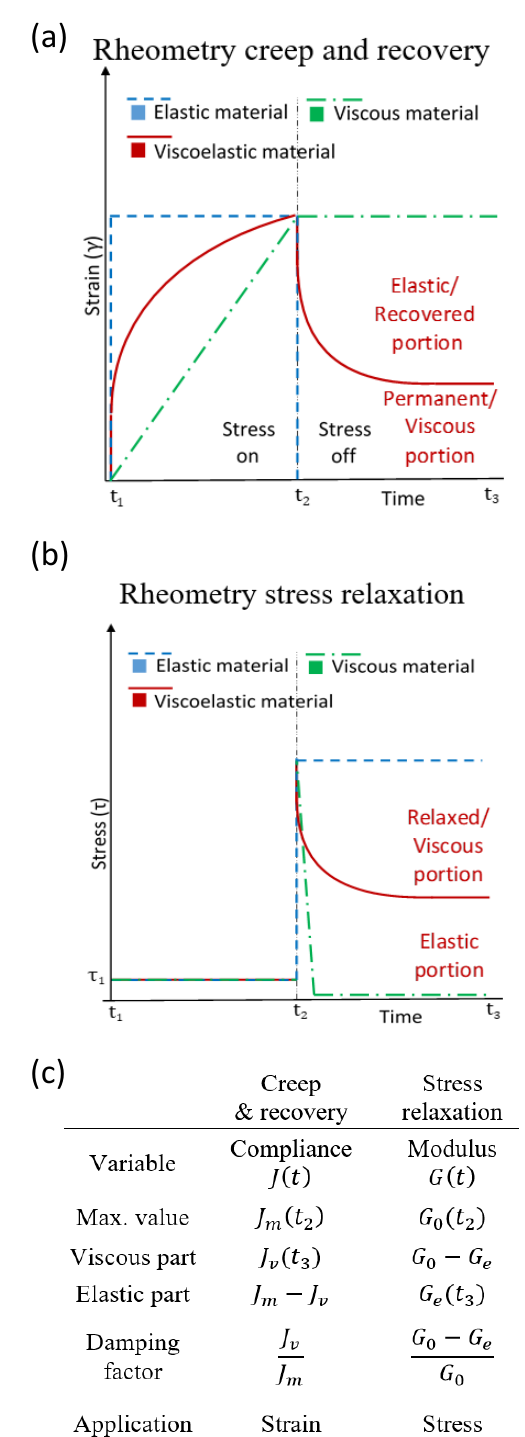
Figure 3. (a) creep and creep recovery test and response, (b) stress relaxation test and response, (c) rheo ‐ viscoelastic damping parameters (t – time, 𝐽(cid:4666)𝑡(cid:4667) (cid:3404) (cid:3082)(cid:4666)(cid:3047)(cid:4667) permission from